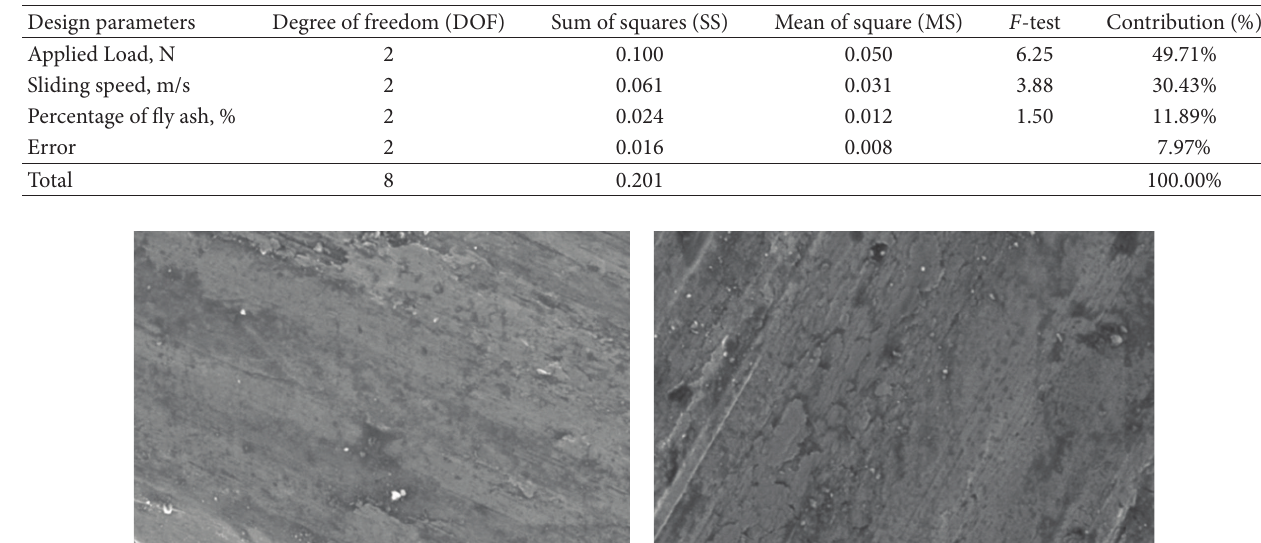
T 9: Results of analysis of variance.